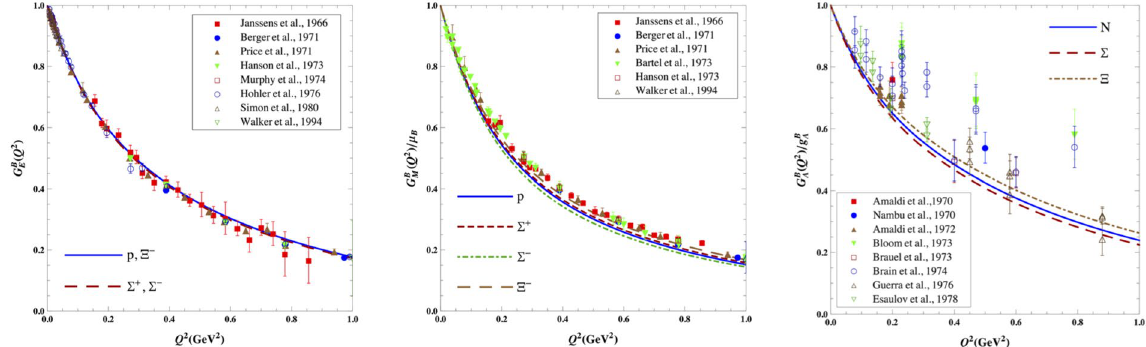
Figure 4. The results of EM and axial form factors in the PCQM taken from refs 32, 33.